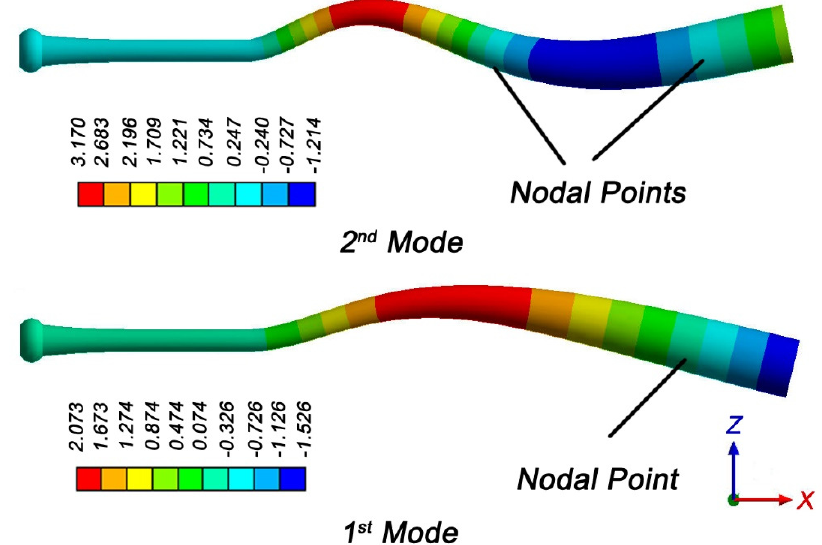
Figure 5. Mode shapes of the bat with its nodal points. Note that the nodal points (nodes) are shown in places on the bat in which the displacement is zero.